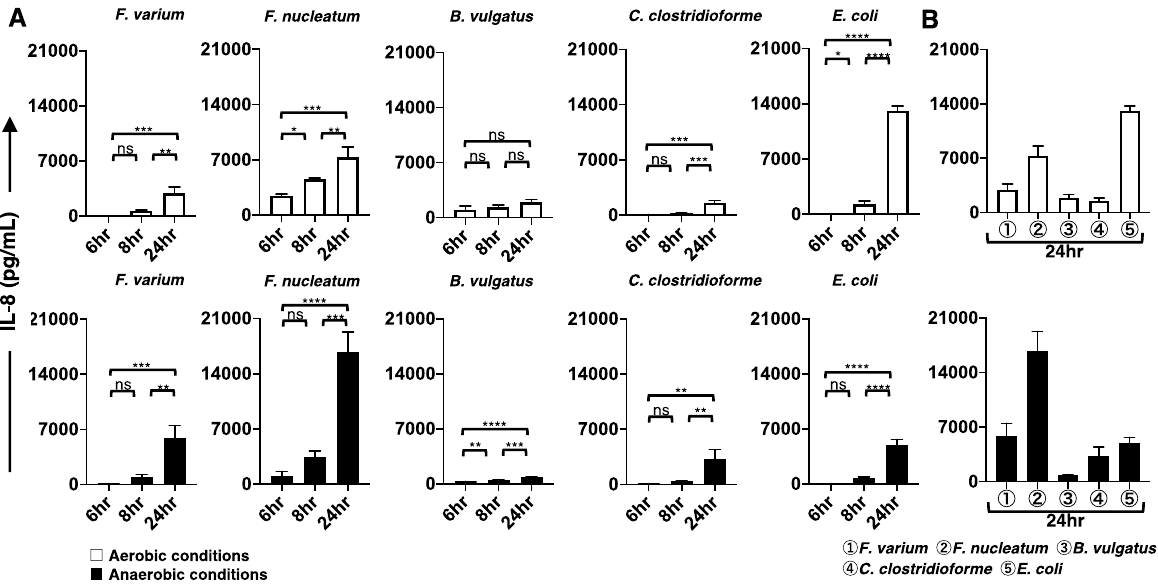
Figure 6. The production of IL-8 by the DC line stimulated with live commensal bacteria. ( A ) Under aerobic (upper panel, white bar) and anaerobic (lower panel, black bar) stimulation conditions, IL-8 production during the initial phase (total of 6 and 8 h) and late phase (a total 24 h) by the DC line after stimulation with six strains of live commensal bacteria was analyzed. ( B ) Under aerobic (white bar) and anaerobic (black bar) stimulation conditions, IL-8 production during the late phase (total of 24 h) by the DC line after stimulation with six strains of live commensal bacteria was analyzed. The six strains of live commensal bacteria are as